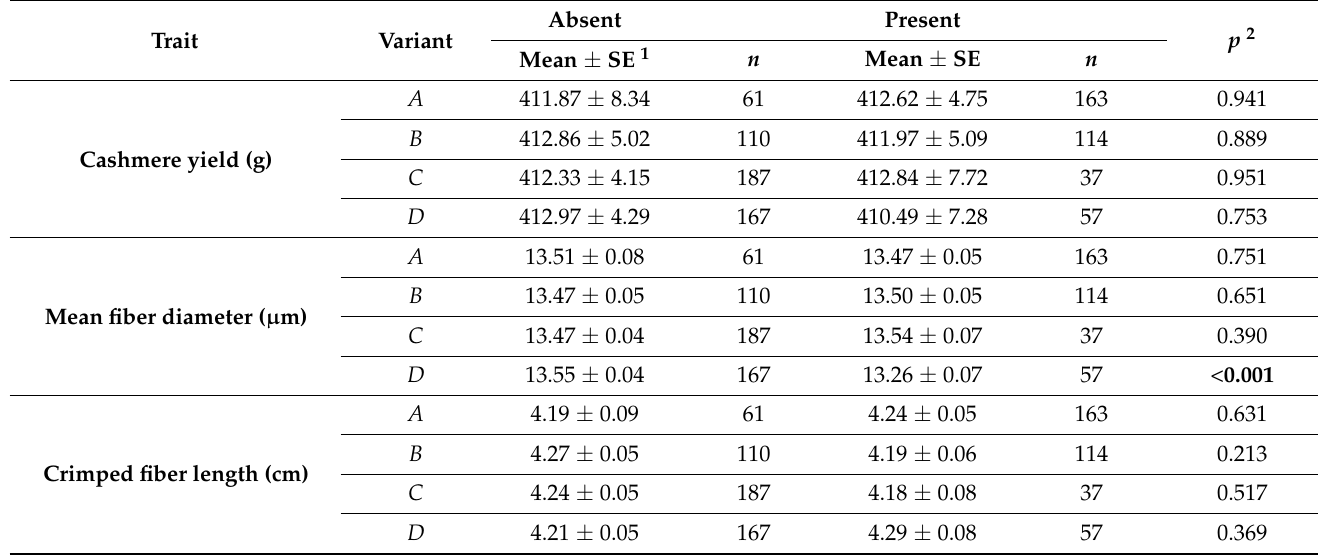
Table 1. Association of caprine KRTAP6-2 variants with cashmere fiber